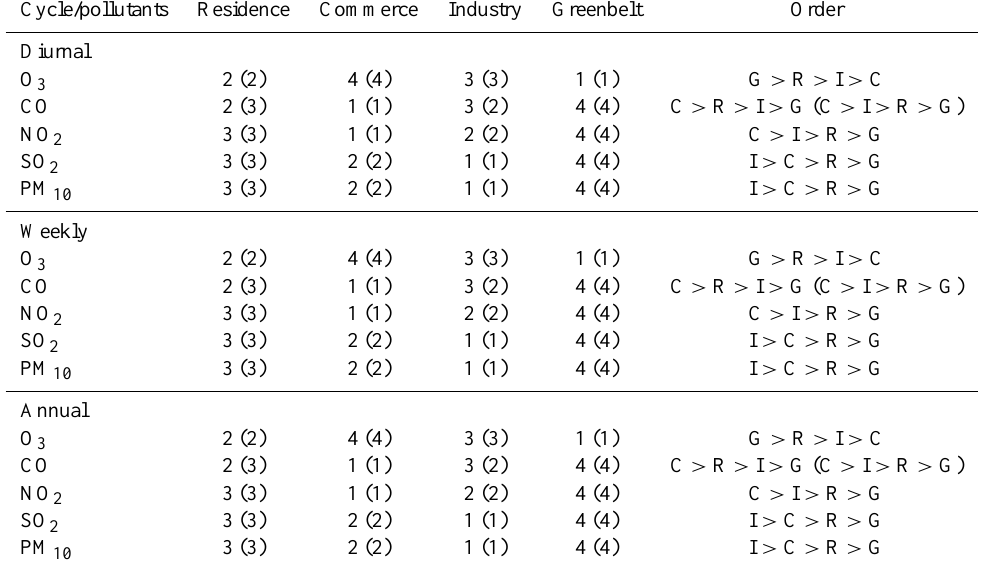
Table 7. The magnitude order of the surface air pollutant concentration averages (O 3 , CO, NO 2 , SO 2 , and PM 10 ) in the diurnal, weekly and annual variations of Fig. 6 over South Korea during 2002–2013 in a 0.25 ◦ × 0.25 ◦ grid in terms of the four land-use types of MEK as follows: residence (R), commerce (C), industry (I) and greenbelt (G). The numbers in the table indicate the ranking of each pollutant, based on the pollutant concentration values over the types. Here, the greater the concentration, the higher the ranking. If the orders in the two grids are different from each other, then those in parentheses have been shown for the 0.1 ◦ × 0.1 ◦